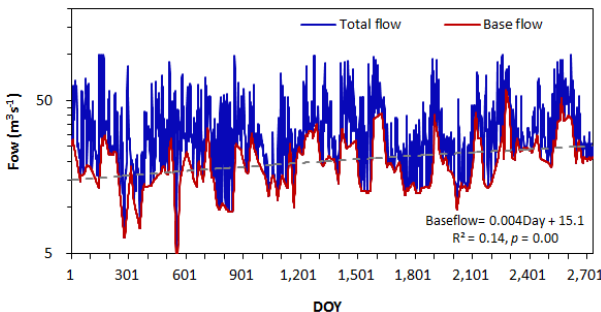
Figure 9. Trend of daily base flow separated from total stream flow measured at the Wuding station during 2006–2013. DOY (day of year) is the number of accumulated days since 1 January 2006.